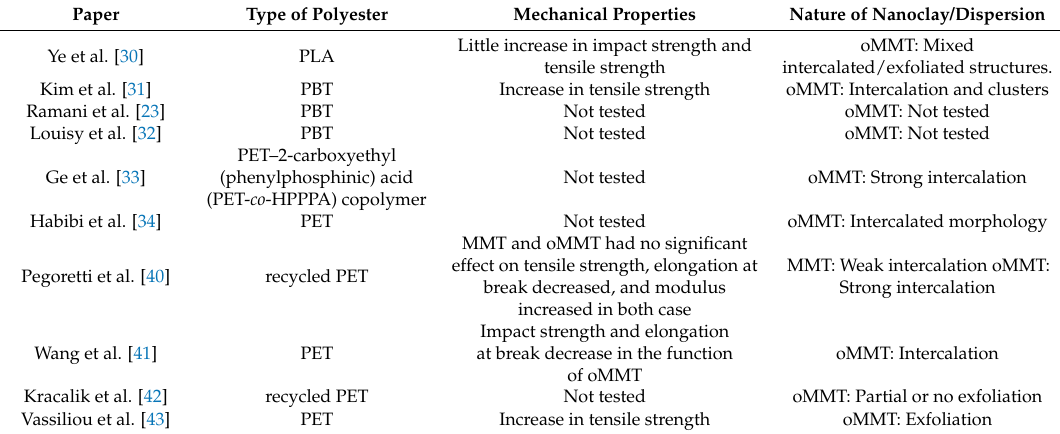
Table 1. Literary summary of polyester/nanoclay composites: Dispersion and mechanical properties of neat and organo-modified montmorillonite (MMT)